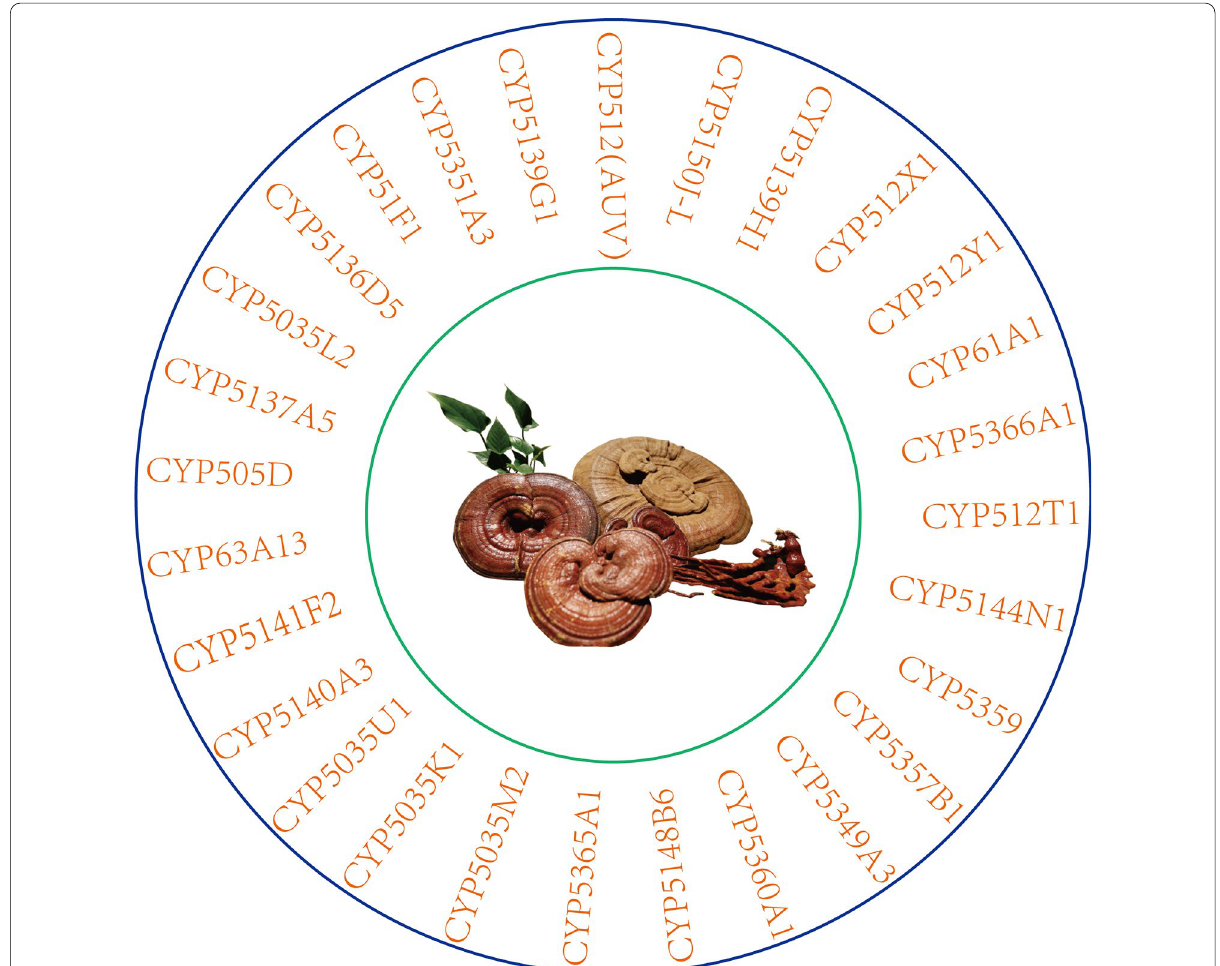
Fig. 7 New family of cytochrome P450 enzymes unique to G.